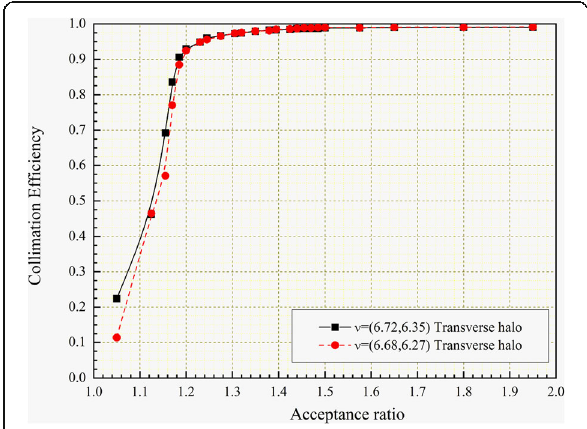
Fig. 22 Simulation results for the J-PARC RCS; collimation efficiency vs aperture ratio of the ring acceptance to the primary collimator aperture, estimated for two kinds of operational betatron tunes